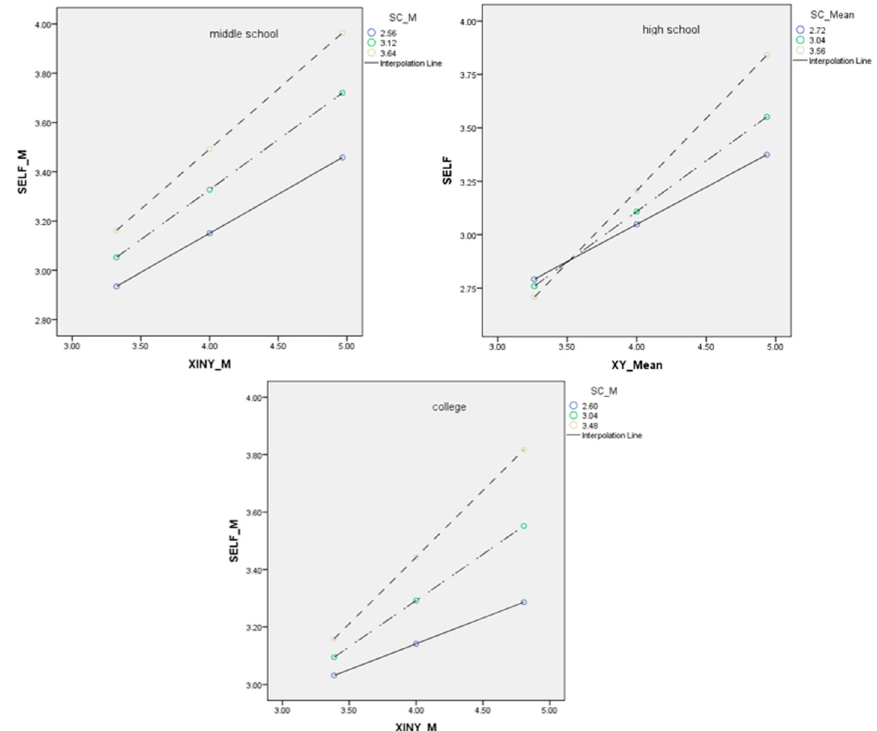
Figure 3. First half path with school climate being the moderator. Note: XINY = spirituality, SELF = Figure 3 . first half path with school climate being the moderator . Note: XINY = spirituality, SELF = self-control, SC = school climate. self-control, SC = school climate.